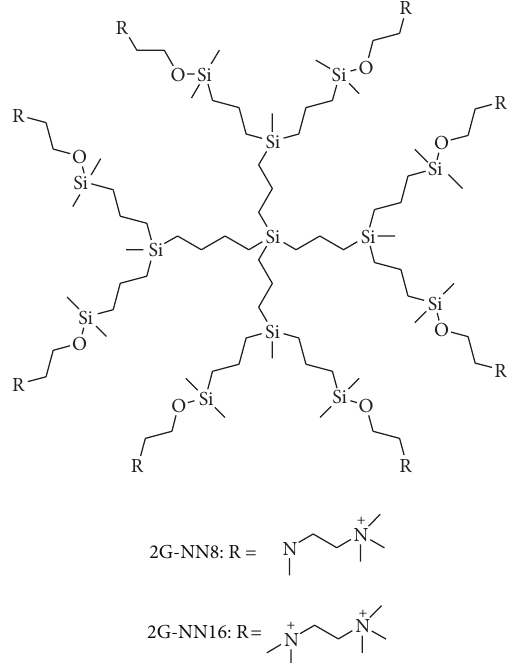
Figure 5: Carbosilane (CBS)